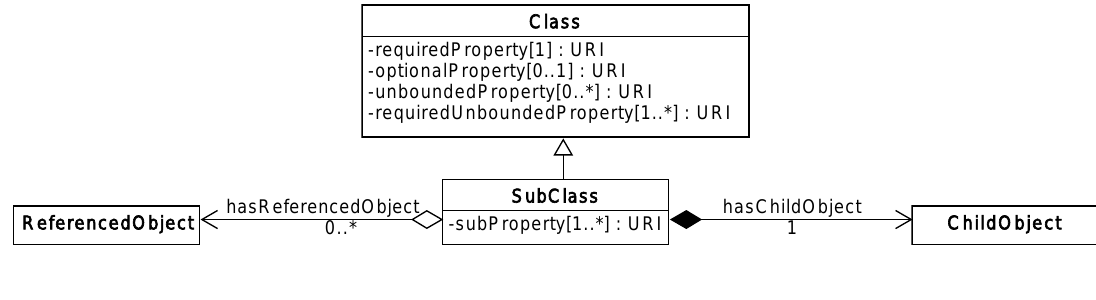
Figure 4: Examples of UML diagram conventions used in this